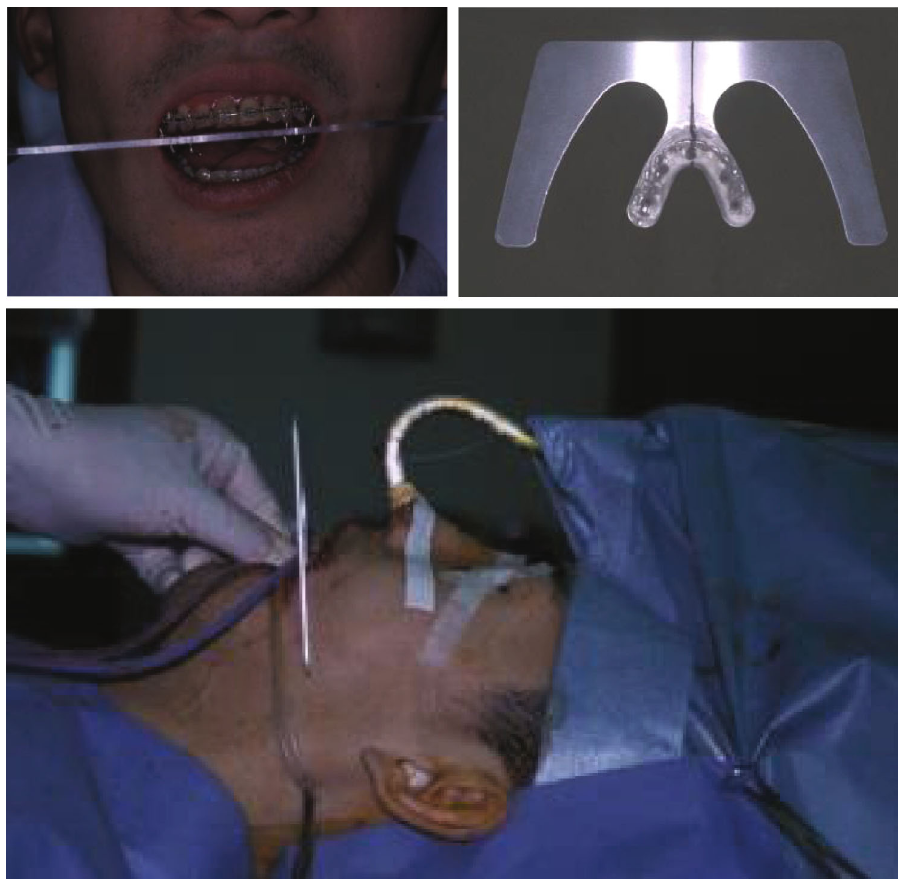
Figure 4: Maxillary positioning using an occlusal plane table as a parallel indicator to Frankfort horizontal